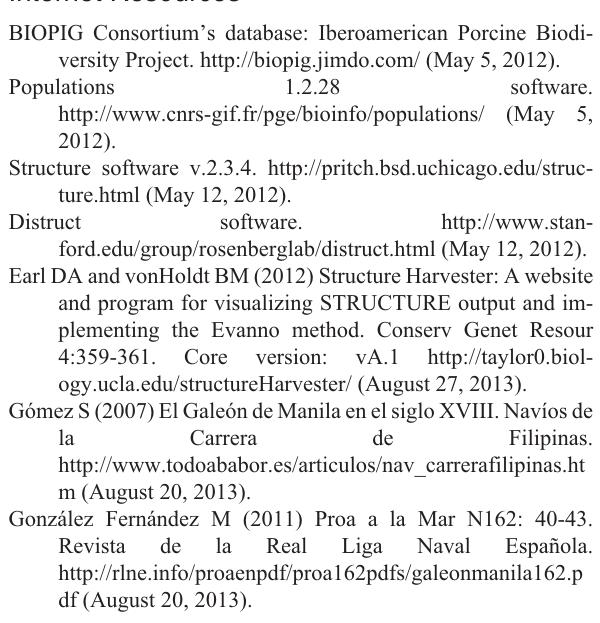
Figure S1 - Pampa Rocha pigs. Figure S2 - Graphical representation of delta